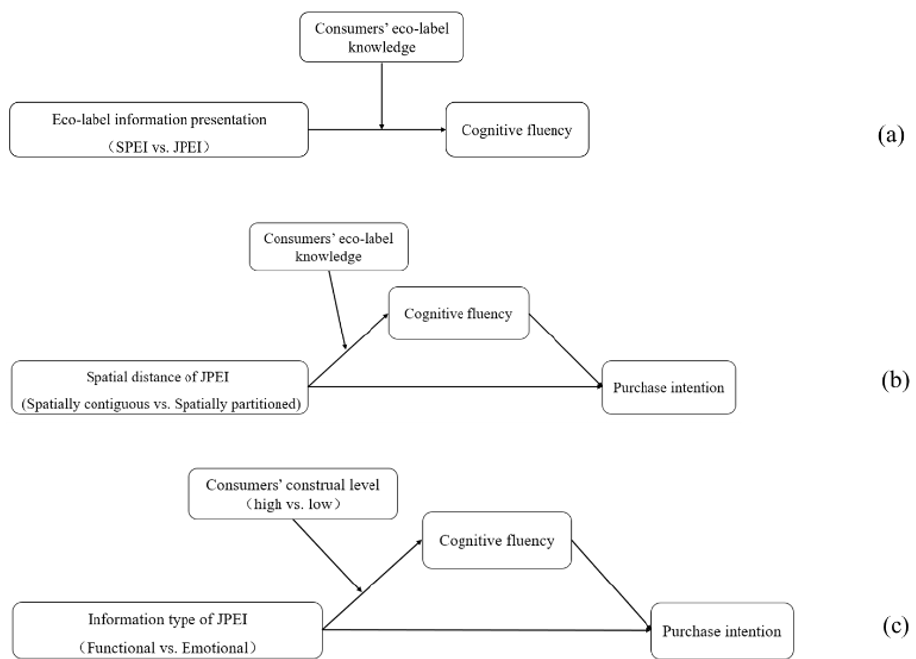
Figure 1. Conceptual model (Note: ( a ) shows H1a and H1b; ( b ) shows H2a and H2b; ( c ) shows H3a and H3b).